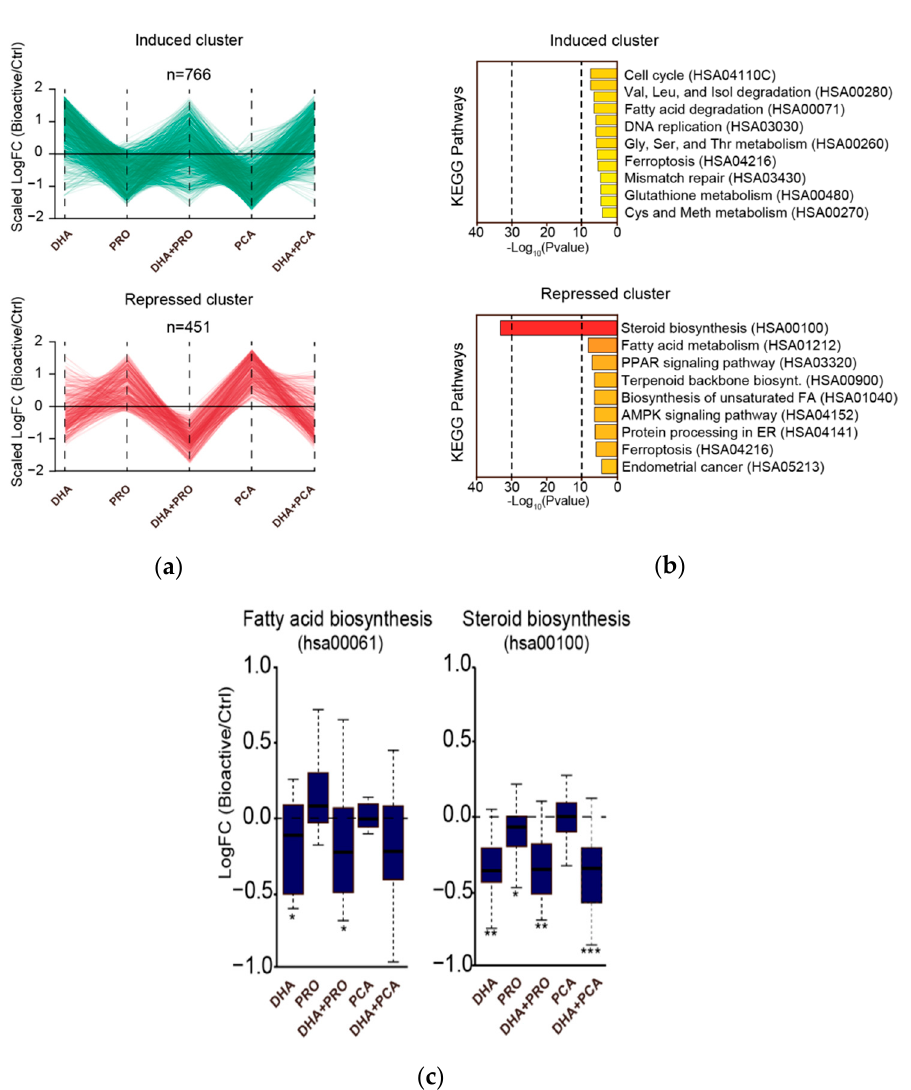
Figure 2. ( a ) Line plots representing scaled log 2 fold changes (FC) following bioactive treatment of all expressed genes (LogCPM > 2) affected by DHA supplementation (abs(LogFC(DHA/Ctrl) ≥ 0)) and assigned to a cluster. The clusters were obtained by initial K-means clustering followed by C-means clustering (using Mfuzz package for R) to obtain genes with a high membership score (>0.8, fuzzification = 2); ( b ) Bar plots illustrating significantly (adjusted p -value ≤ 0.05) induced and repressed pathways within each cluster, respectively. Performed using enrichKEGG function in clusterProfiler package for R; ( c ) Boxplots illustrating the log 2 fold change in expression of genes belonging to the KEGG pathways hsa00061 (fatty acid biosynthesis) and hsa000100 (steroid biosynthesis) following bioactive treatment (* p < 0.05, ** p < 0.005, *** p < 0.0005). Consistent with this, we found 3-hydroxy-3-methylglutaryl-CoA reductase gene ( HMGCR ) to be one of the transcripts most repressed by DHA. HMGCR encodes the rate-limiting enzyme of